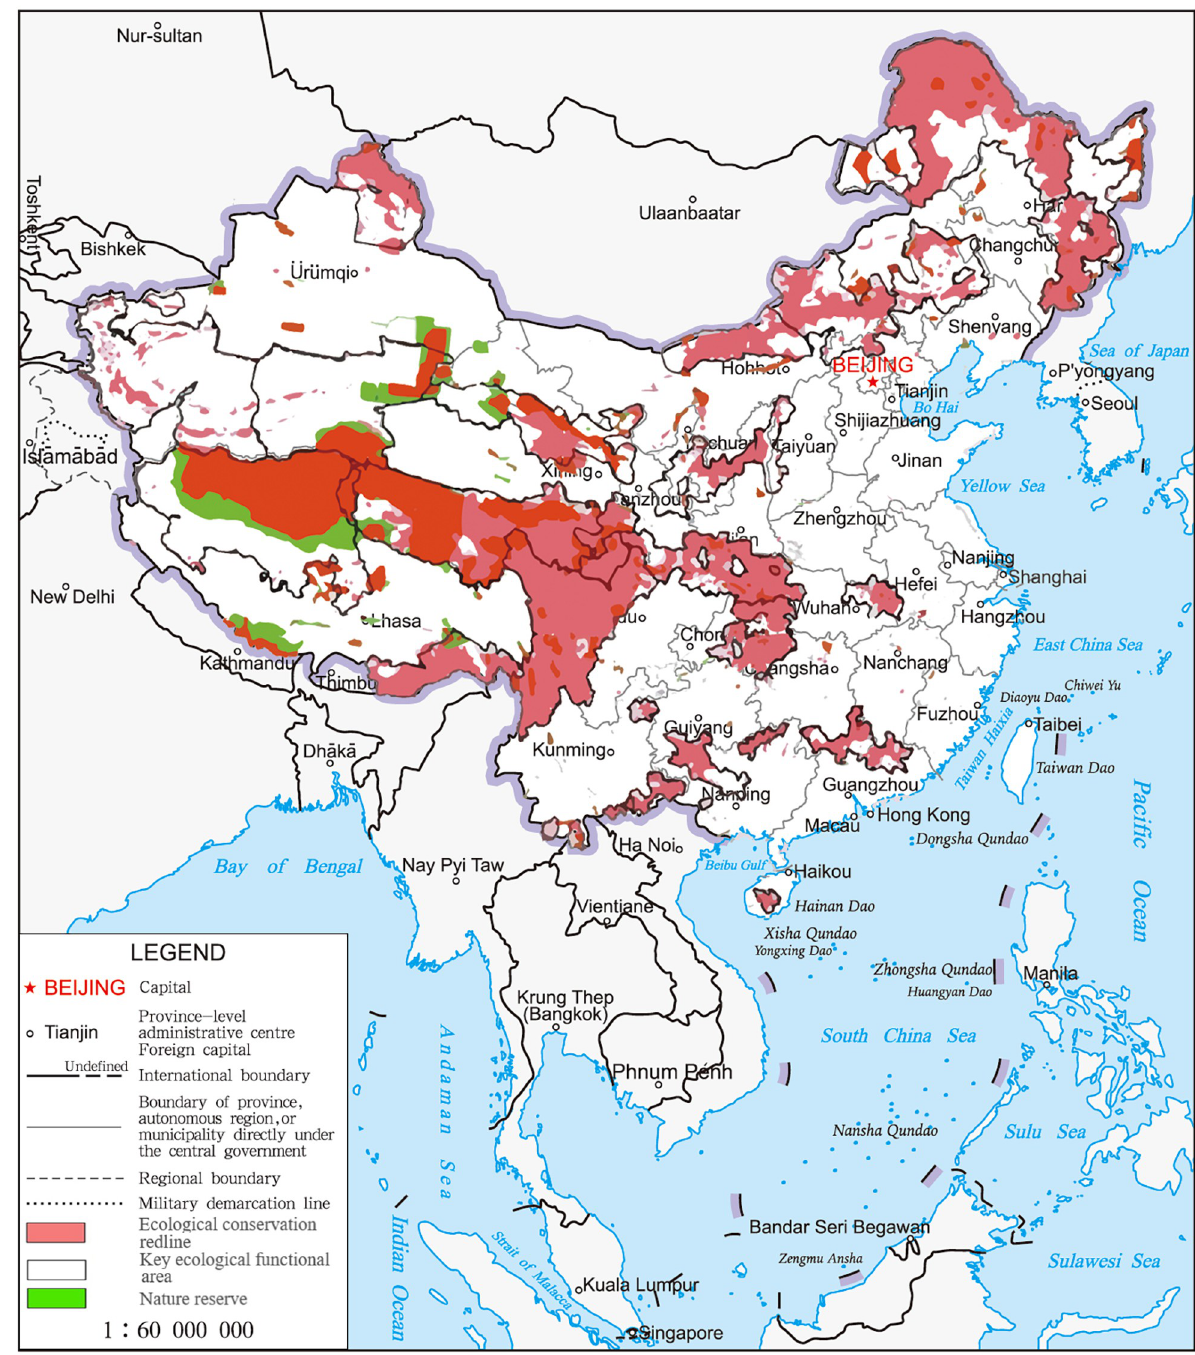
Fig 1. Study area—Ecological conservation redline spatial distribution in